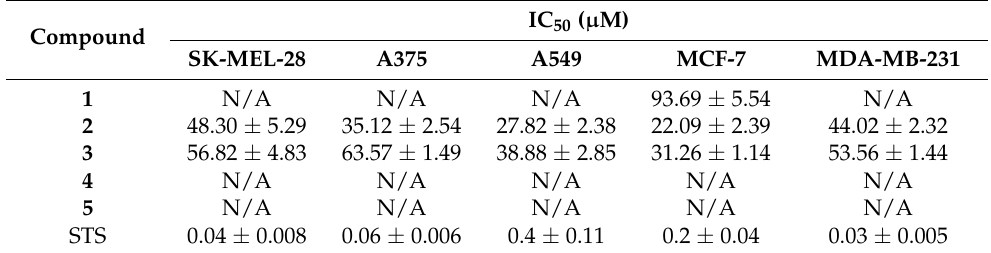
N/A: Not active; STS: Staurosporine used as a positive